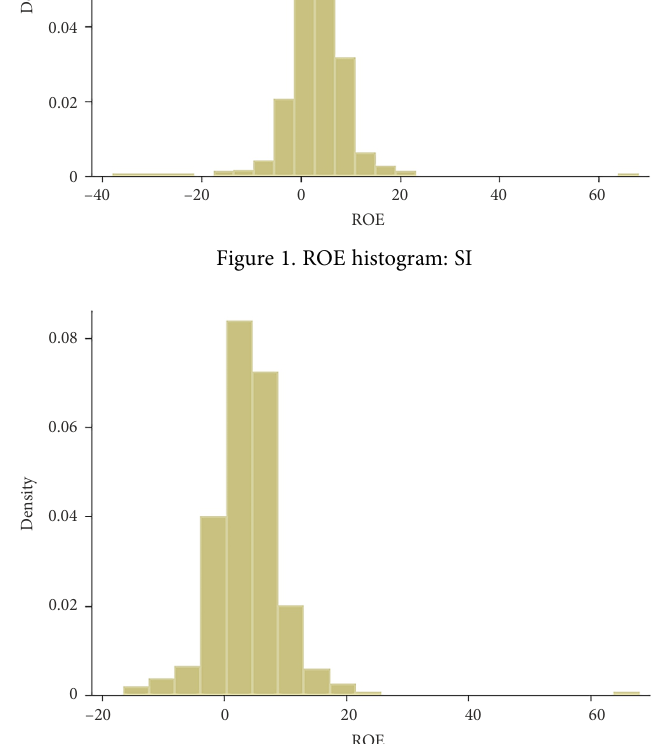
Figure 2. ROE histogram: IC-design